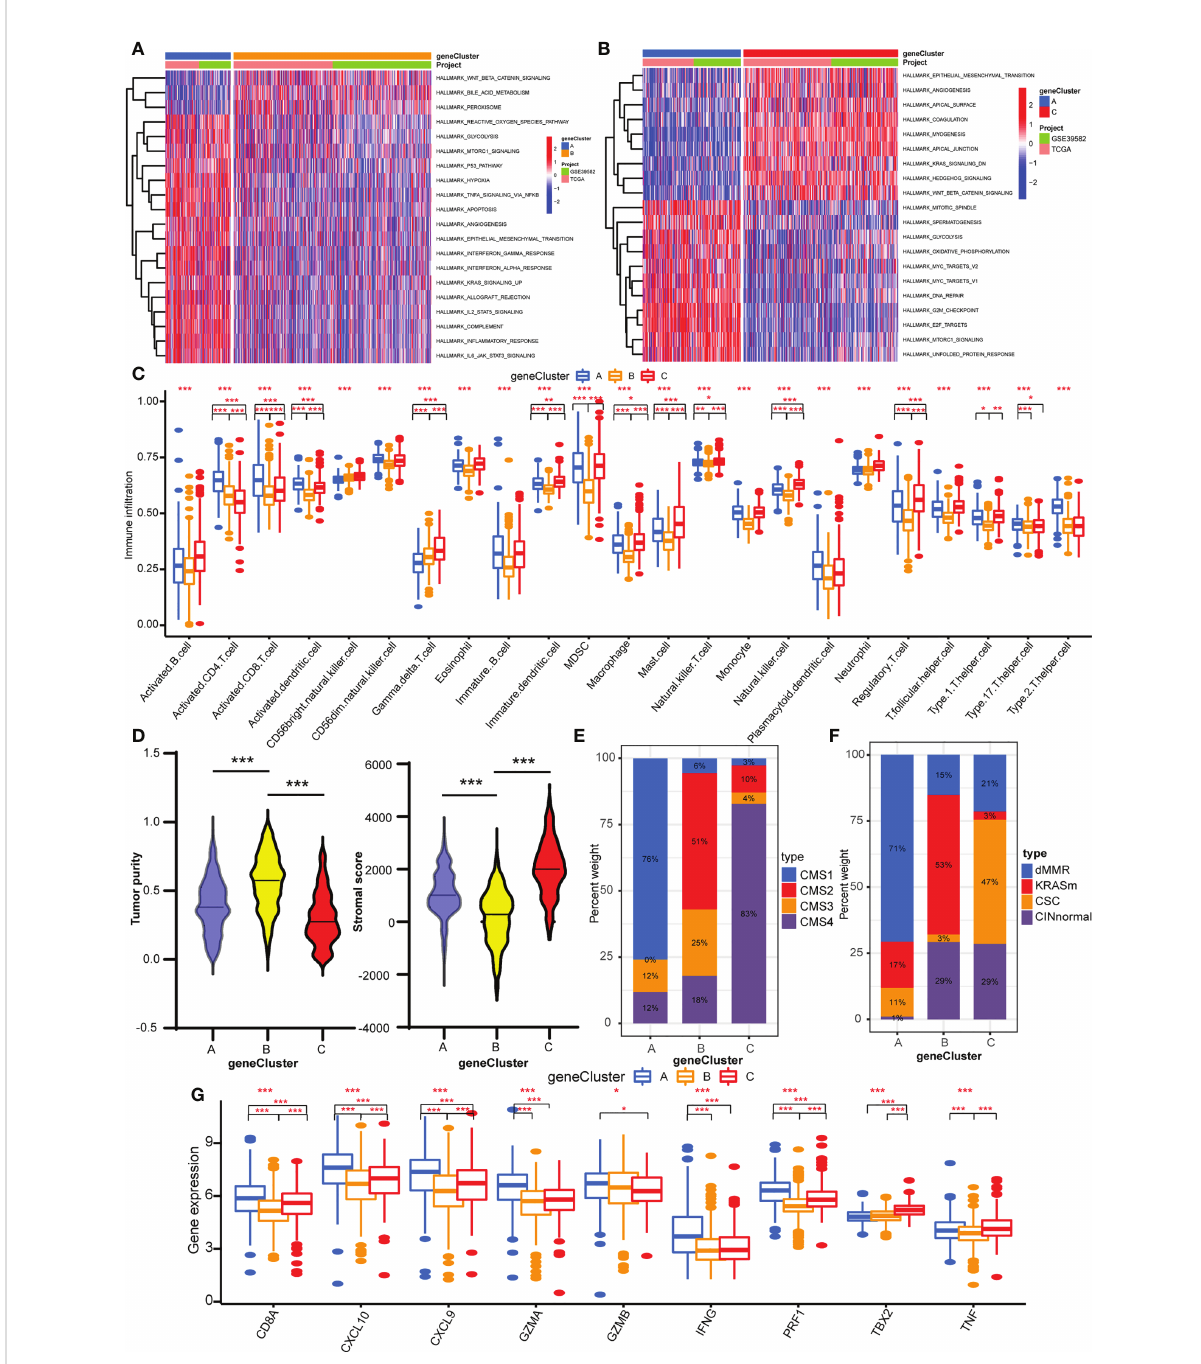
FIGURE 4 TME characteristics of three geneClusters. (A) The heatmap of GSVA results between geneCluster A and geneCluster B. (B) The heatmap of GSVA results between geneCluster A and geneCluster C. (C) The abundances of TME in fi ltrating immune cells in three geneClusters by ssGSVA algorithm. (D) The stromal score and tumor purity in three geneClusters by ESTIMATE algorithm. (E) The CMS analysis of the three geneClusters. (F) The molecular subtypes analysis of GSE39582 dataset in three geneClusters. (G) The expression of immune activated genes between three geneClusters. *P <0.05; **P <0.01; ***P